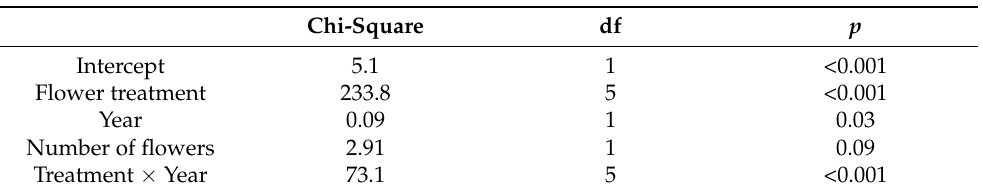
Table 1. Effects of flower treatment, year, their interaction, and the average number of flowers on the average number of pollinator visits to the plots. Chi-square values and degrees of freedom (df) were derived via a general linear mixed model.